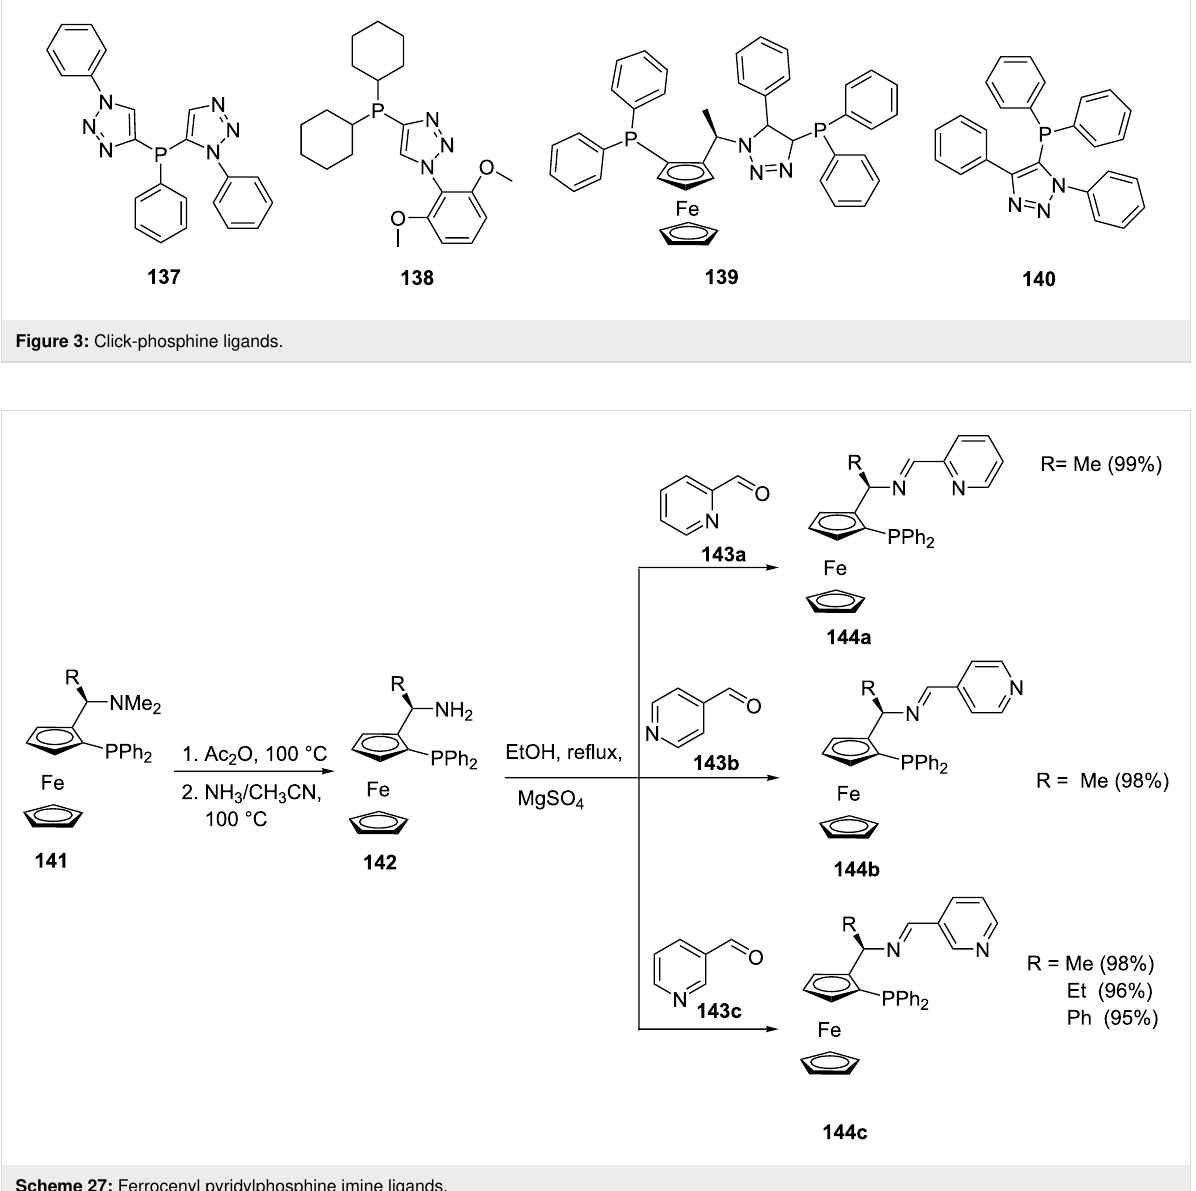
Scheme 27: Ferrocenyl pyridylphosphine imine